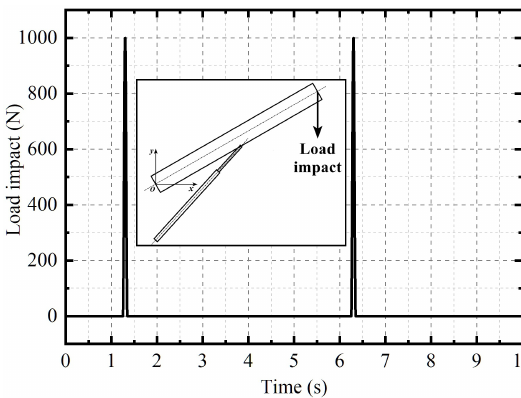
Figure 20. Load impact.